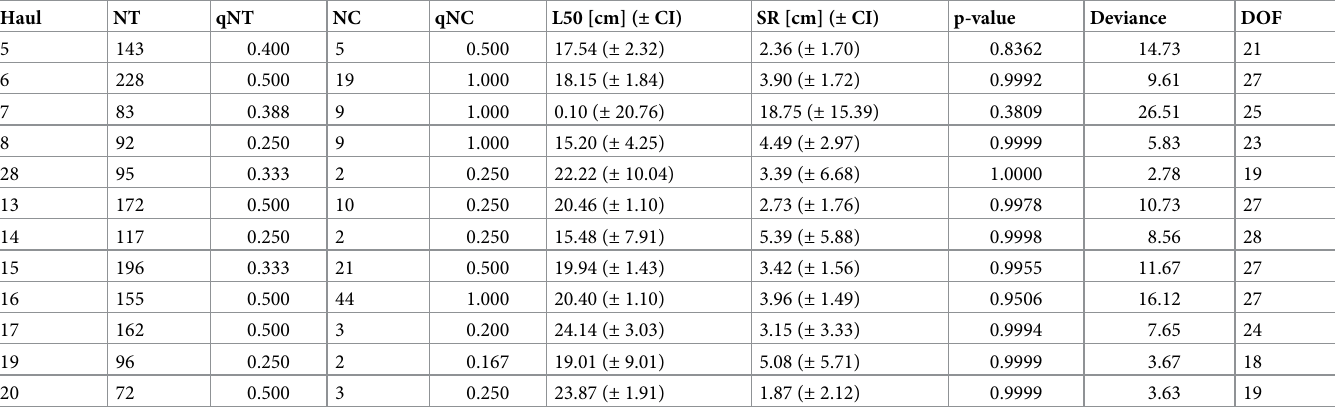
Table 6. Estimated selection parameters and fit statistics for Norway lobster (12 hauls). Haul NT qNT